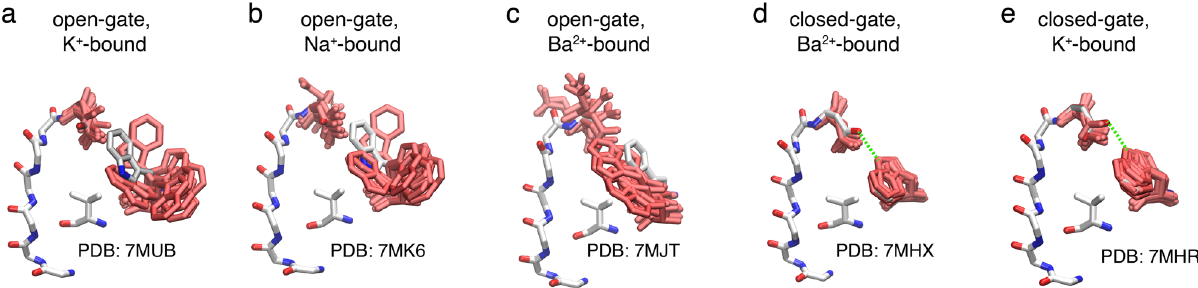
Fig. 8 The dynamics of the W67 and D80 side chains in MD simulations. a Open-gate and K + bound, b open-gate and Na + bound, c open-gate and Ba 2 + bound, d closed-gate and Ba 2 + bound, and e closed-gate and K + bound. The crystal structures are shown as reference (labeled with their PDB ID) in licorice representation and carbon atoms in white with multiple snapshots from simulations. The side-chain conformations are shown in red licorice, and these snapshots are selected for every 100 ns in all four